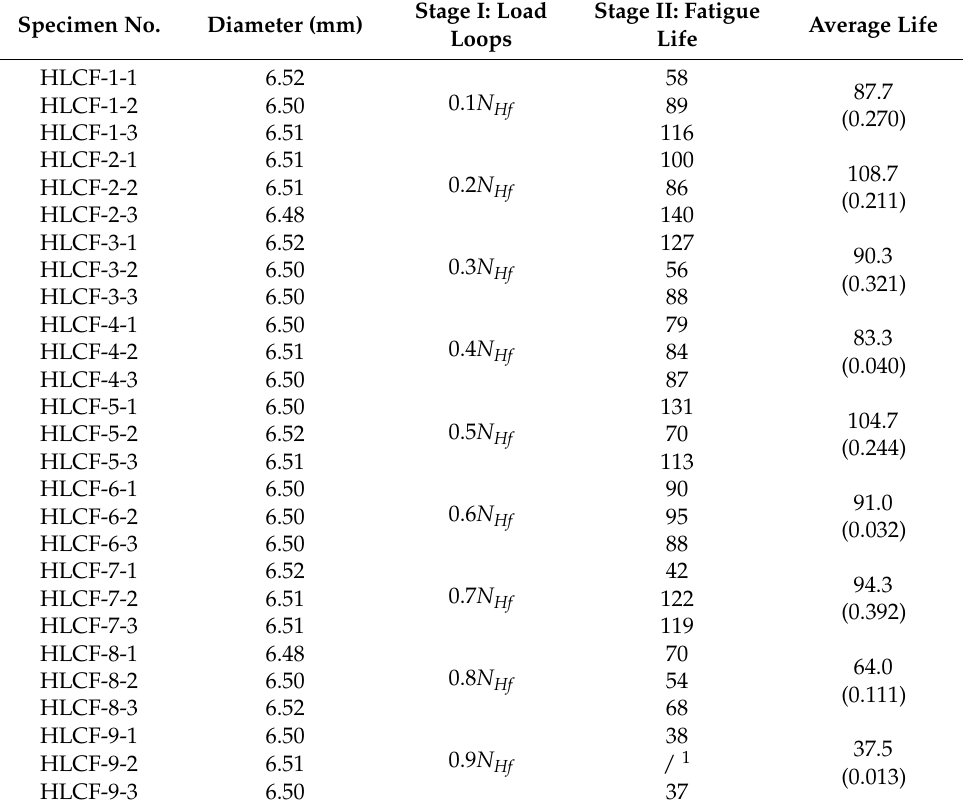
Table 4. Test results of the combined high and low cycle fatigue. Specimen No. Diameter (mm)